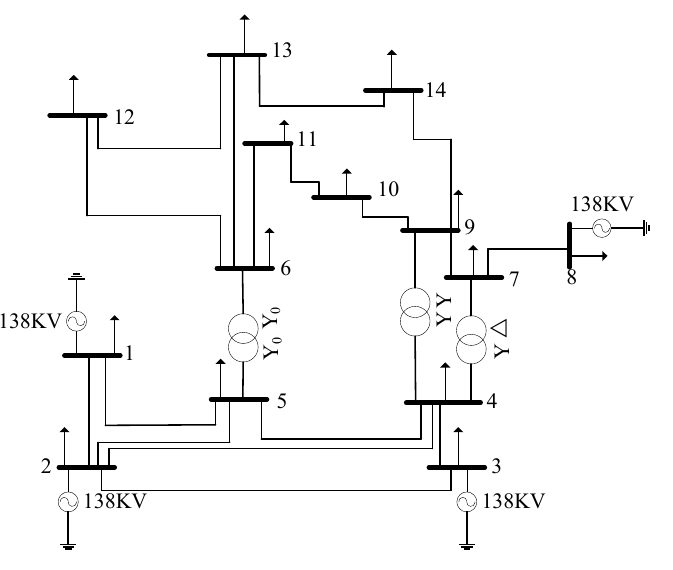
Figure 6. IEEE14 node system.